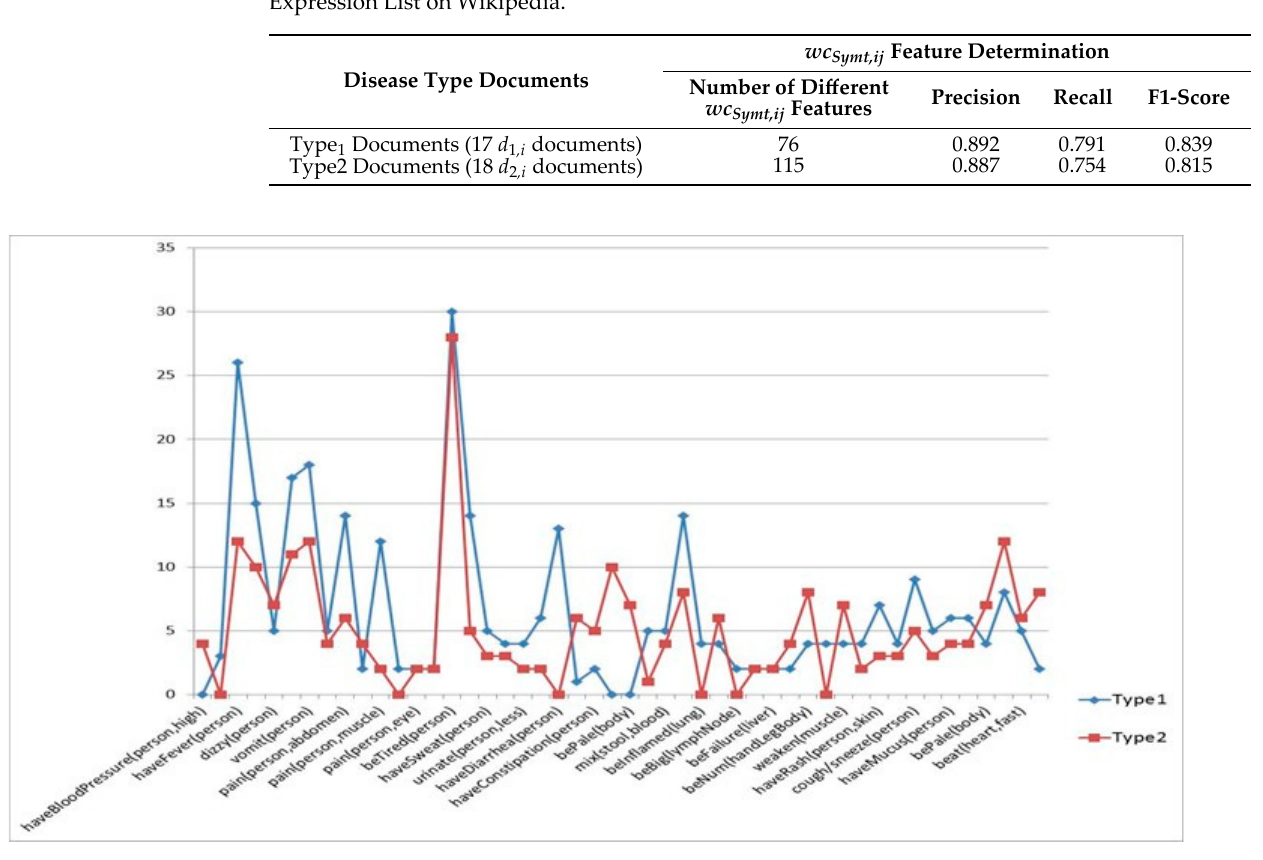
Figure 8. The frequencies of the correct determined wc Symt,ij features from 35 different d i documents containing the 17 d 1 ,i documents in Type 1 and the 18 d 2 ,i documents in Type 2